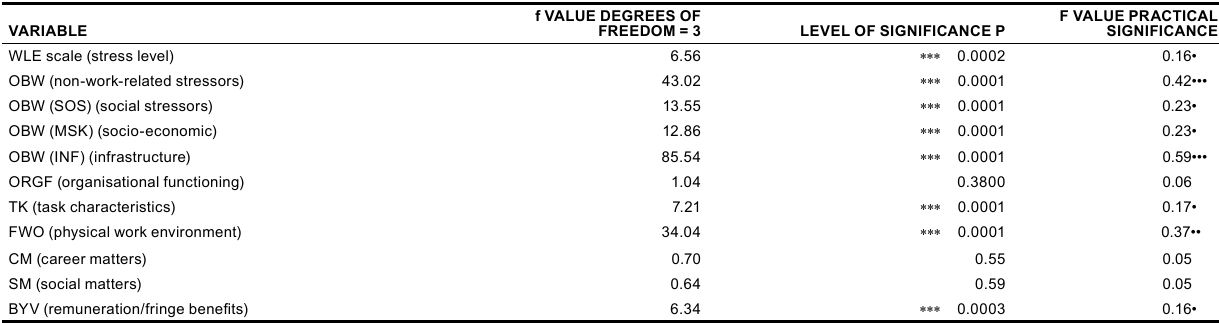
table 1 Significance of the differences in the various racial groups on the scales and